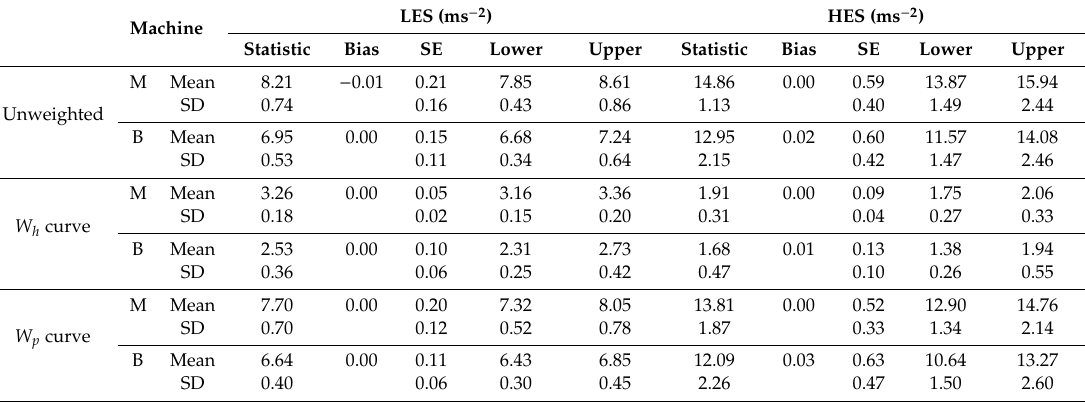
Table 4. The bootstrap method (1000 bootstrap samples) applied to the hand-arm vibration total values (VTVs) (unweighted and with the application of the W h and W p weighting curves).